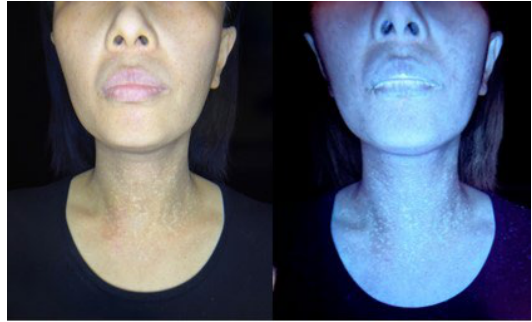
Figure 1. Mottled hyperpigmentation and hypopigmentation on the neck are distinctive features in patients with Riehl’s melanosis. Wood’s lamp examination showed accentuation of macules. (Left: Room light, right: Wood’s lamp, Dermlite Lumio2) .